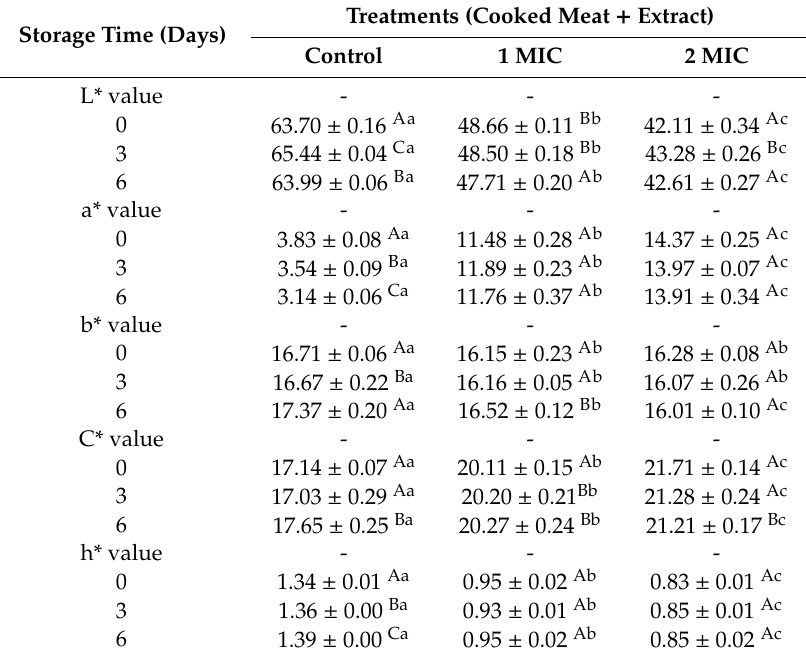
Table 3. Color changes of the cooked pork treated with ATCE during